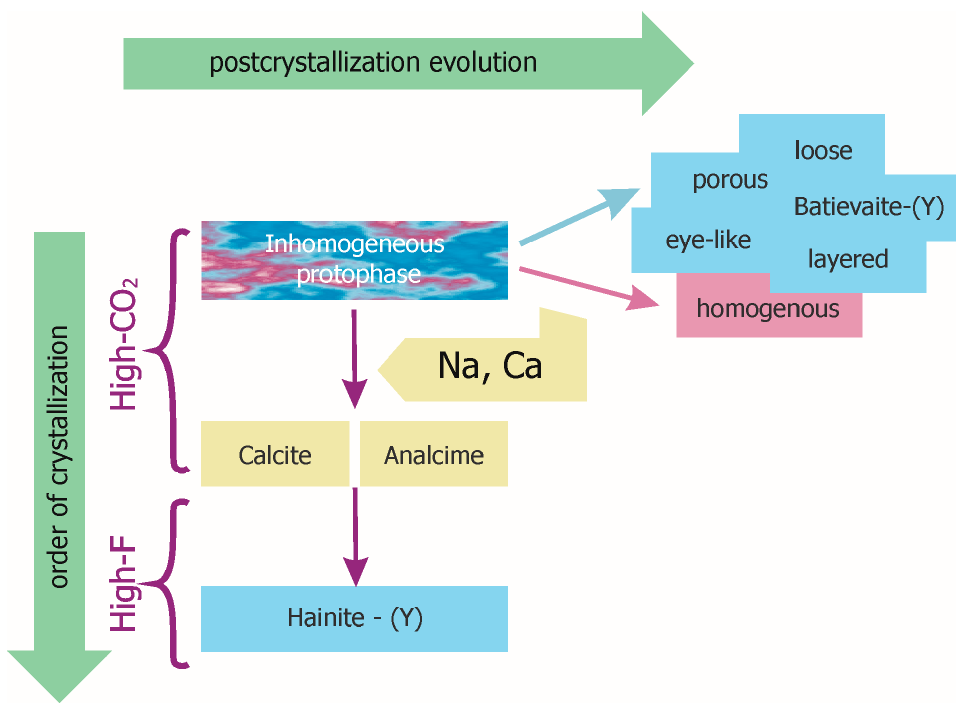
Figure 4. Relationship scheme of the hainite-(Y)-batievaite-(Y) series .